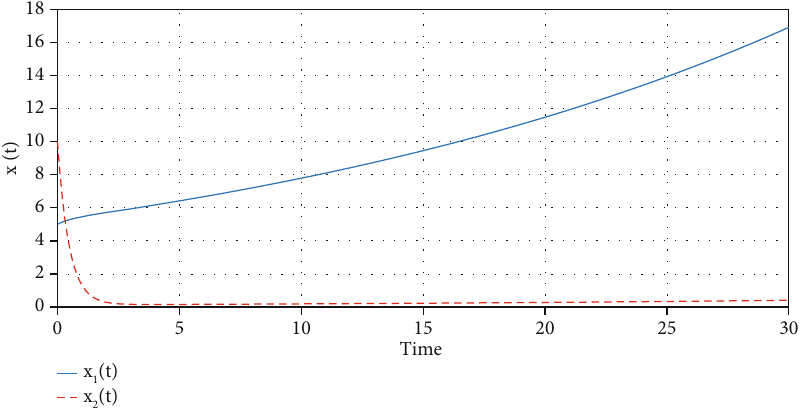
Figure 2: State response of the second subsystem.